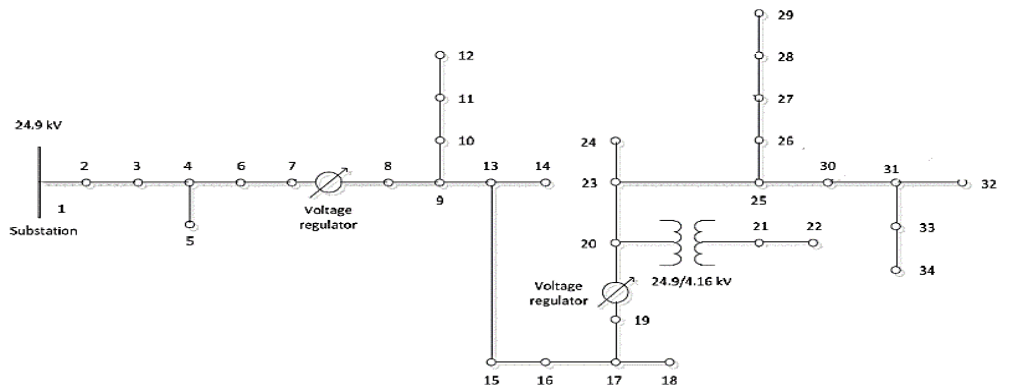
Figure 2. IEEE 34-bus unbalanced distributed system.